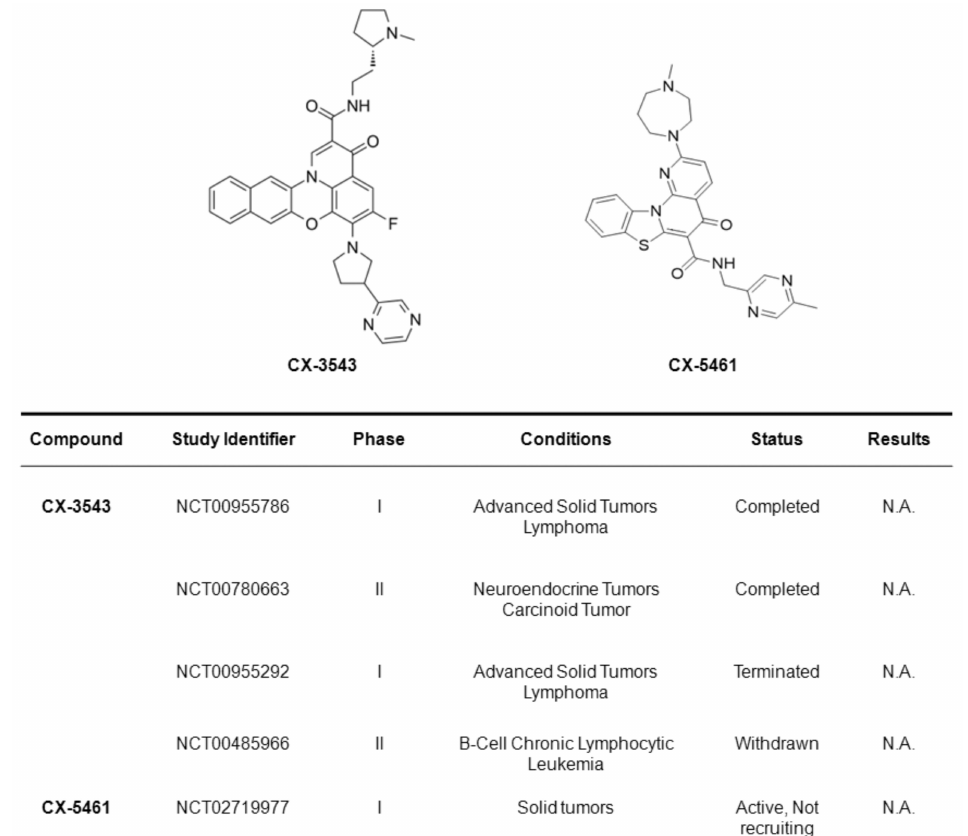
Figure 4. The chemical structures of the two G4 ligands under clinical testing and the related clinical trials have been reported. Study identifiers and information have been retrieved from